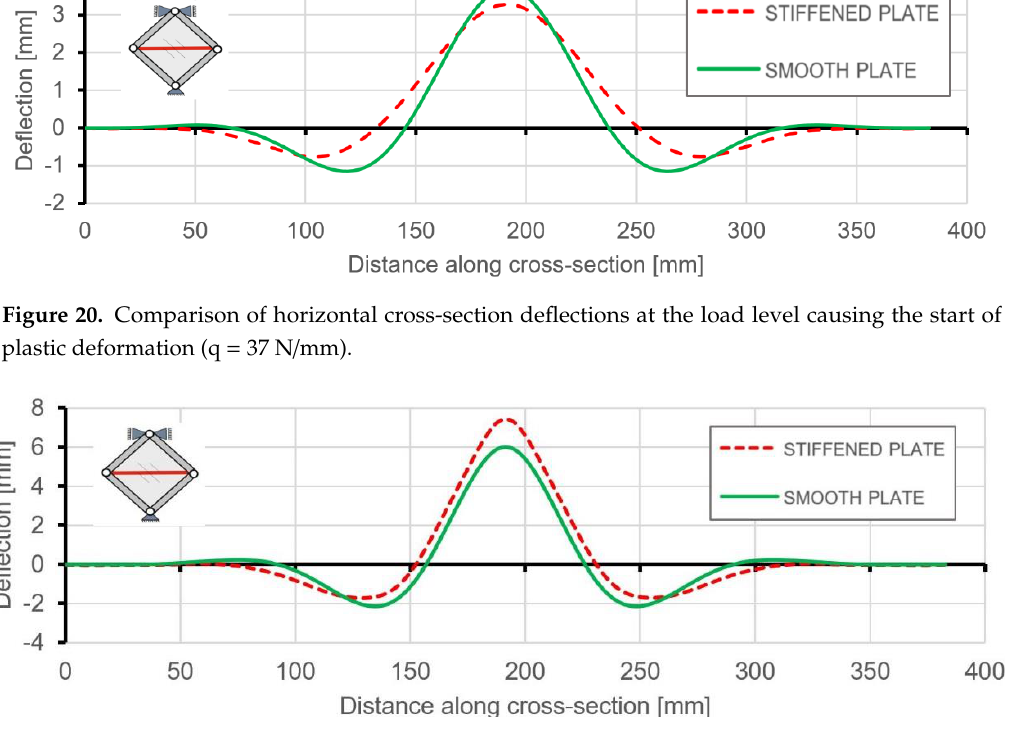
Figure 21. Comparison of horizontal cross-section deflections at the maximum load level equal to 103 N/mm.